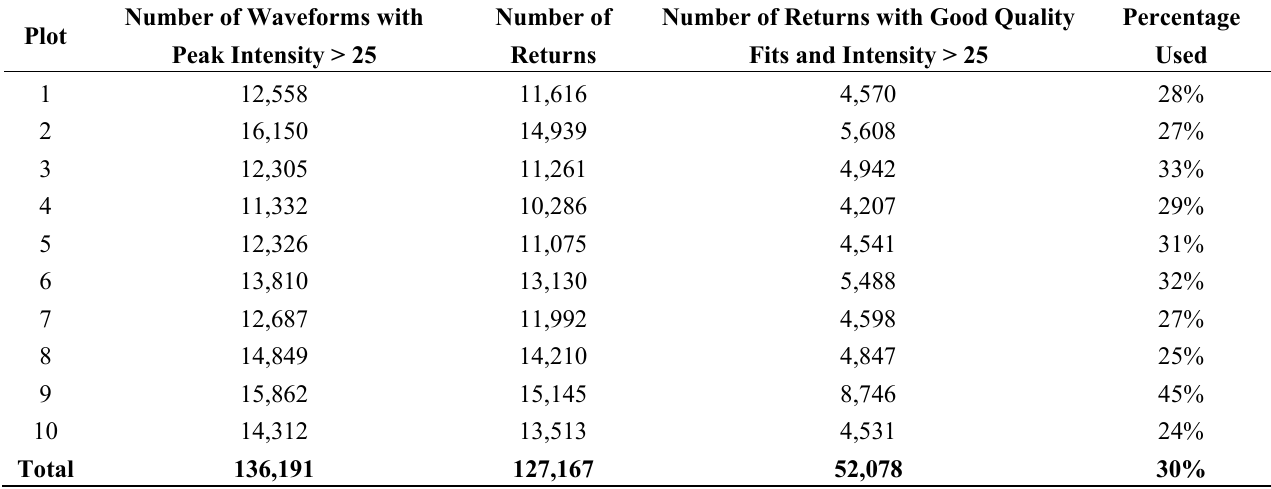
Table 1. Summary of number of returns analyzed for the ten field plots with leaf area density